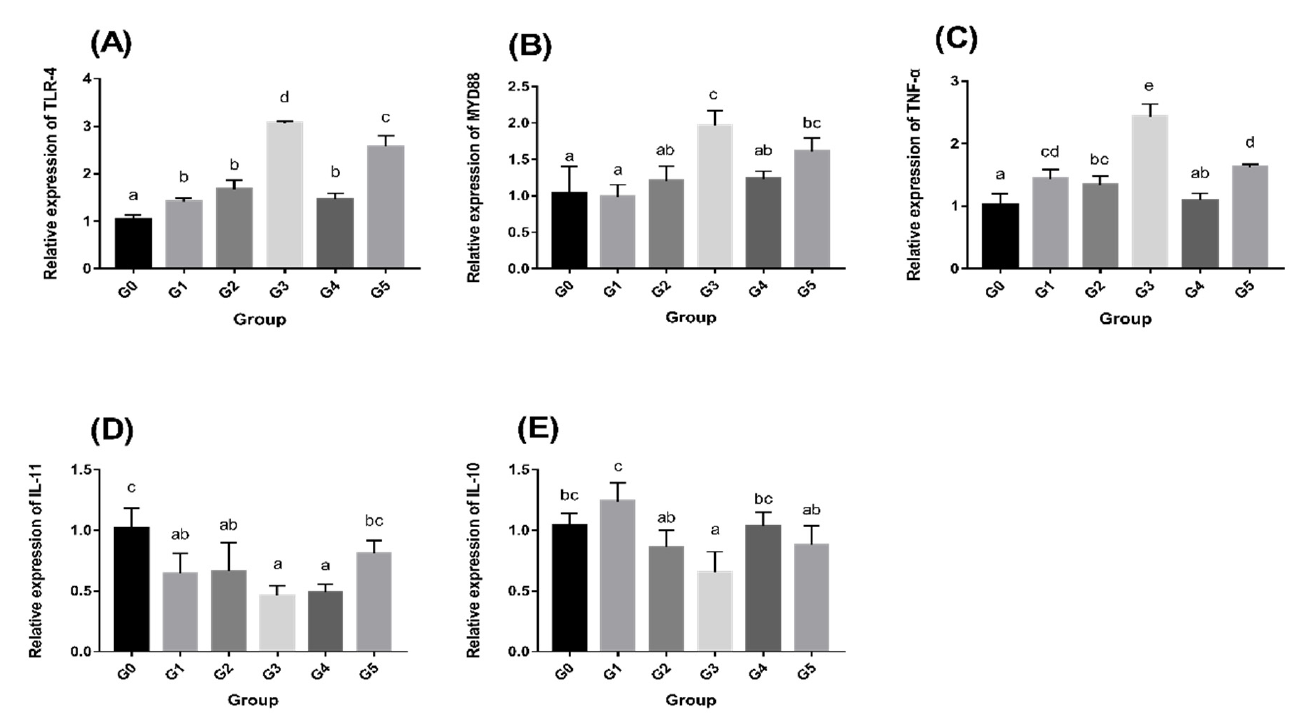
Figure 1. Intestinal immune-related gene expression levels after the addition of AMPs. ( A ) Relative expression of TLR-4 ; ( B ) Relative expression of MYD88 ; ( C ) Relative expression of TNF- α ; ( D ) Relative expression of IL-11 ; and ( E ) Relative expression of IL-10 . The values represent the means with standard errors ( n = 3). Values which do not have a common superscript differ significantly ( p < 0.05).